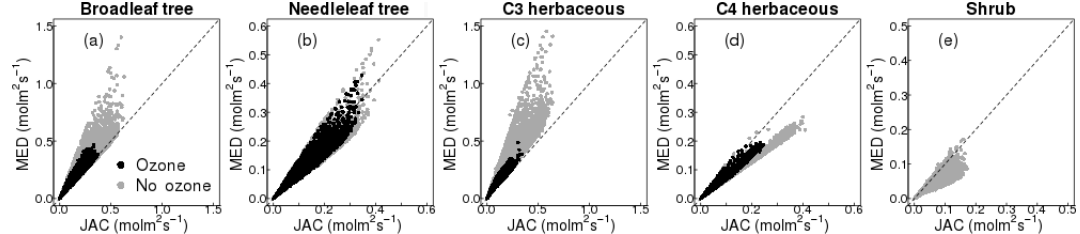
Figure 2. Comparison of simulated g s with MED ( y axis) versus JAC ( x axis) for all five JULES PFTs at one grid point (lat: 48.25, long: 5.25); shown are hourly values for the year 2000.